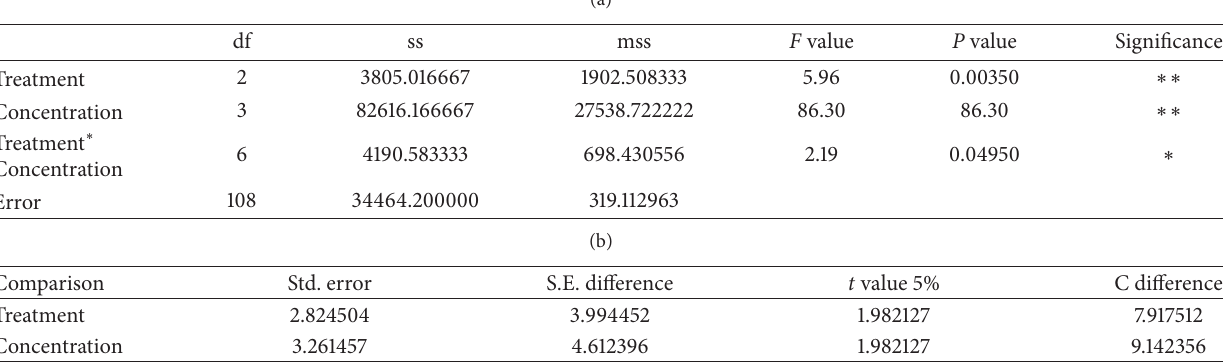
Table 2: One-way ANOVA to compare the disinfectants and concentrations.